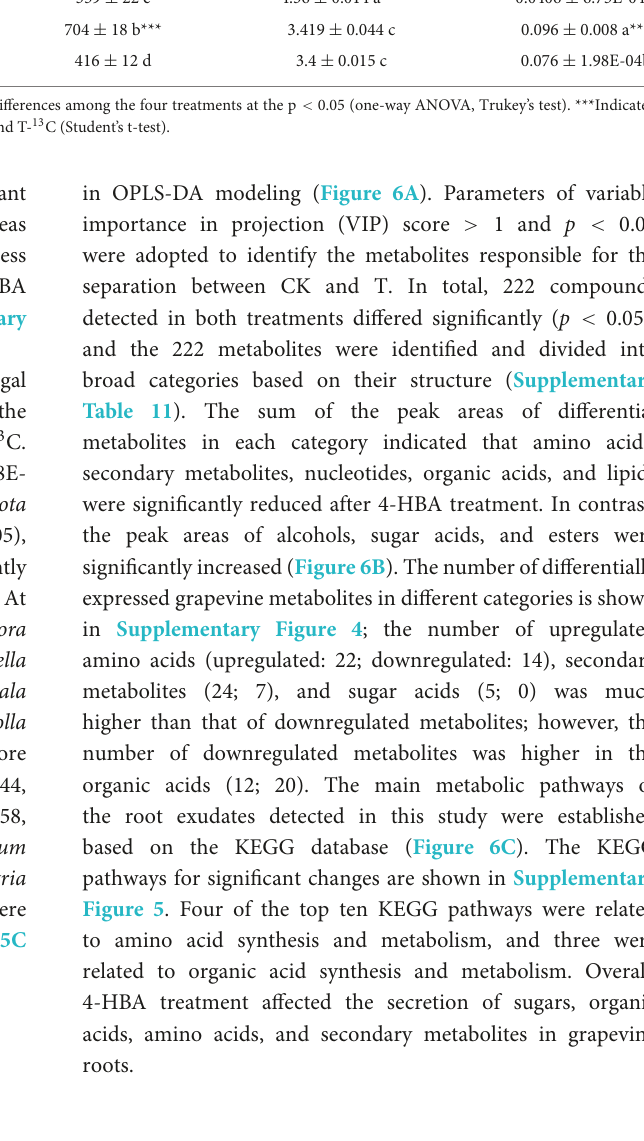
Figure 5 . Four of the top ten KEGG pathways were related to amino acid synthesis and metabolism, and three were related to organic acid synthesis and metabolism. Overall, 4-HBA treatment affected the secretion of sugars, organic acids, amino acids, and secondary metabolites in grapevine